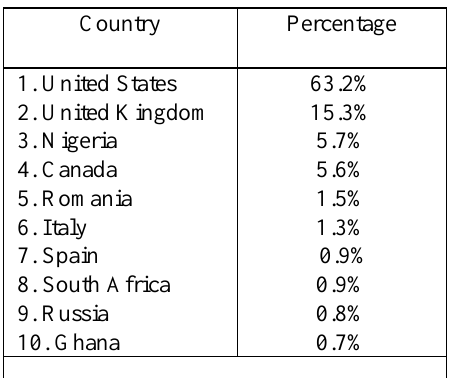
Table 1. Top Ten Countries by Count